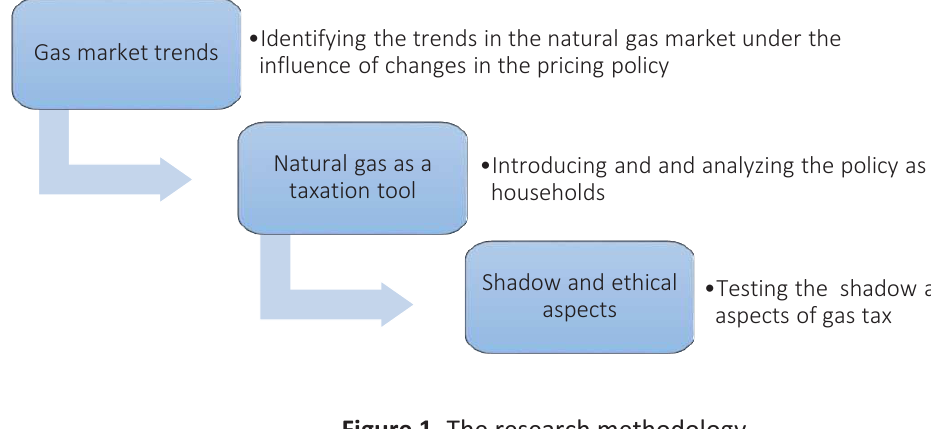
Figure 1. The research